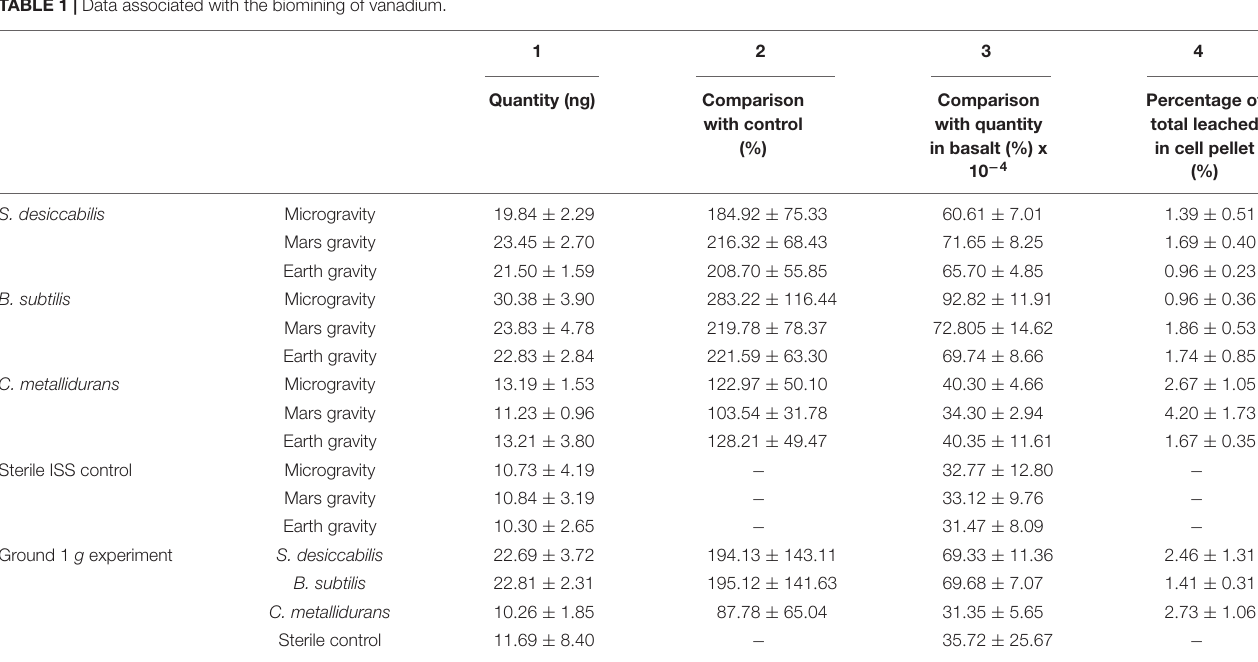
FIGURE 2 | Bioleaching and control leaching of vanadium from basalt on the International Space Station (ISS) and on Earth. Total quantities (ng) of vanadium in each of the experimental flight and ground control samples at the end of the experiment for each of the three organisms examined and sterile samples. (cid:13) shows single measurements and the mean is given as red (cid:3) . Error bars represent standard deviations. n = 3, except for sterile controls in microgravity and the ground experiment, in which n = 2 due to contamination. Data in Supplementary Table 1 . TABLE 1 | Data associated with the biomining of vanadium.